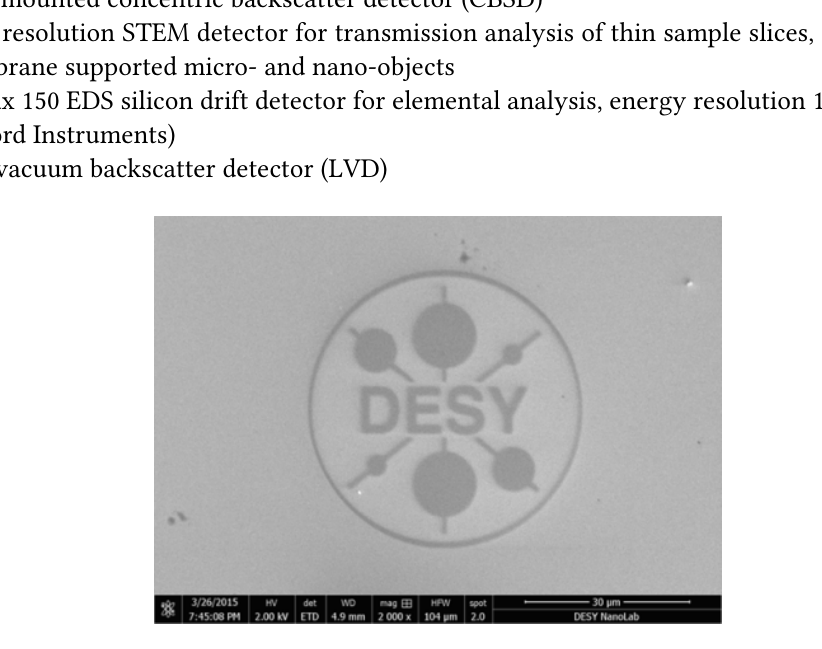
Figure 4: DESY logo written by electron beam assisted deposition of platinum on a silicon wafer